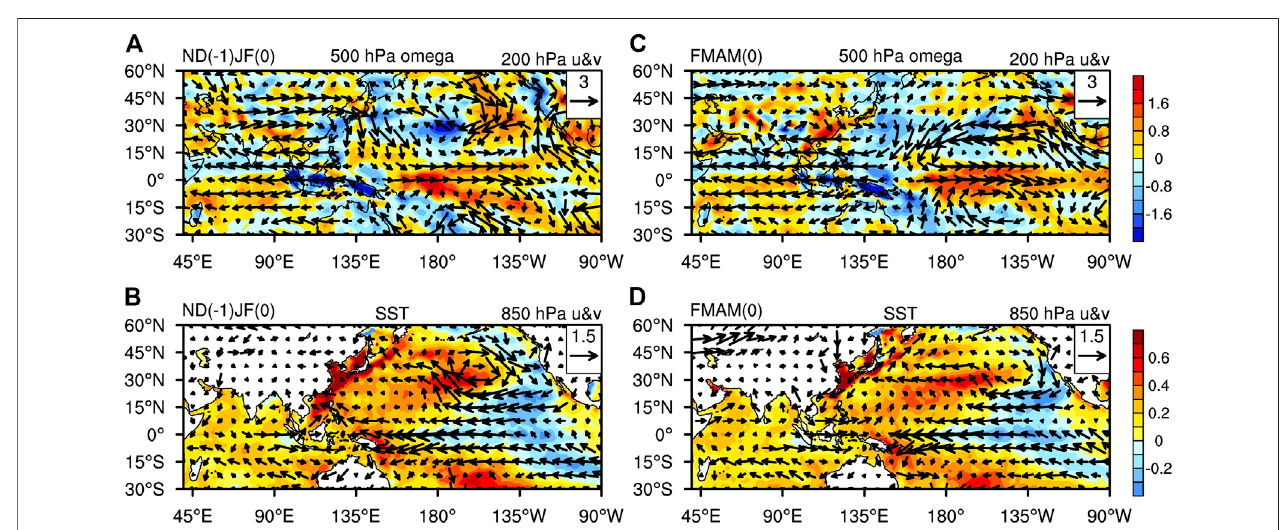
FIGURE 10 | Epochal differences of (A) 200 hPa wind (arrows, m/s) with 500 hPa p-velocity (shading, 10 – 2 Pa/s), and (B) 850 hPa wind (arrows, m/s) with SST (shading, K) for November – February. (C) , (D) same as (A) , (B) but for February – May. “ (1) ” denotes (1993 – 2016) minus (1979 – 1992), " (0)" denotes (1994 – 2017) minus (1980 –